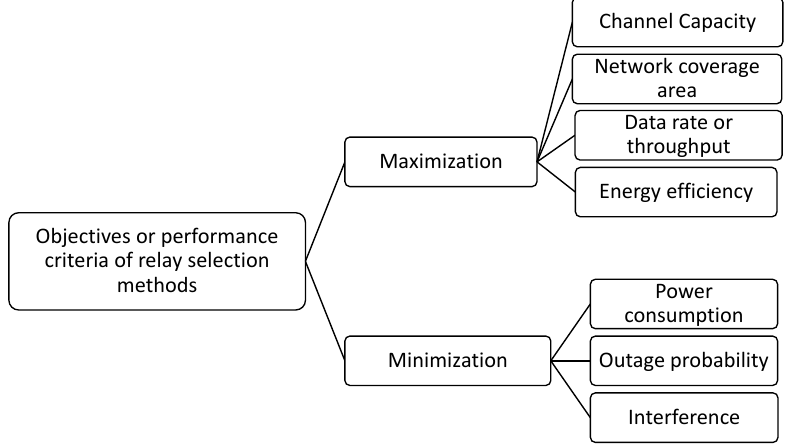
Figure 4. Taxonomy of relay selection methods in cooperative wireless sensor